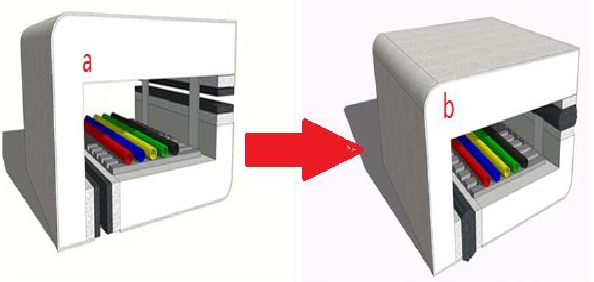
Figure 2. Sectional views of the cable tray protector before and after thermal expansion of the CSR – IFR module: ( a ) daily state and ( b ) closed state in the event of a fire.